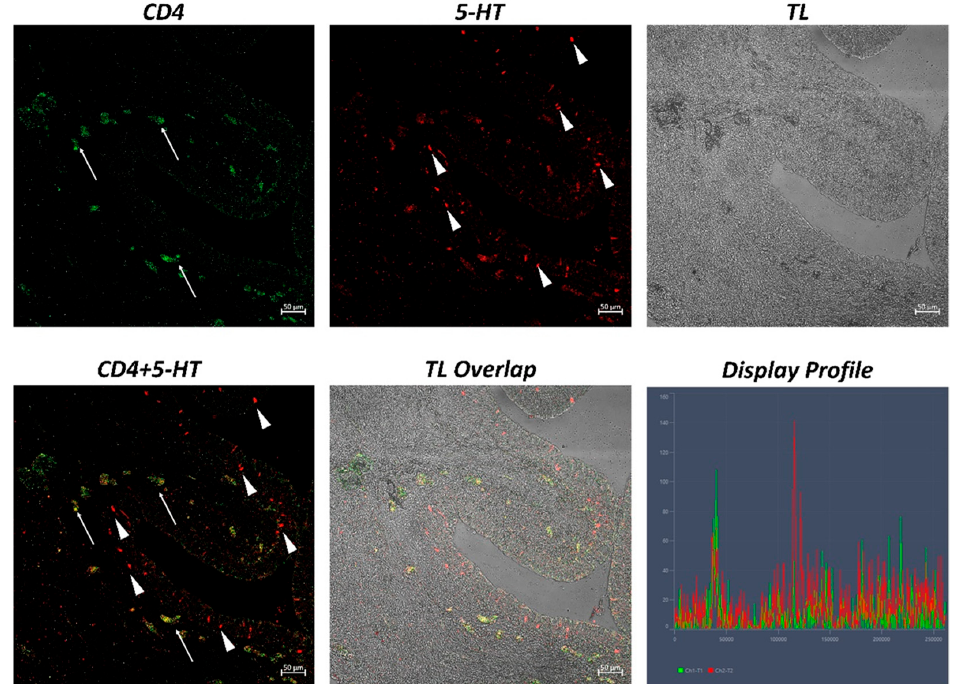
Figure 5. Section of the H. niloticus gut (immunofluorescence 20 × , scale bar 50 µ m). Lymphocytes that are positive for CD4 and 5-HT are scattered in the submucosa (arrows). The presence of neuroendocrine cells that are immunoreactive to 5-HT can also be noted (arrowheads). The “Display profile” function highlights the colocalization. TL = transmitted light.